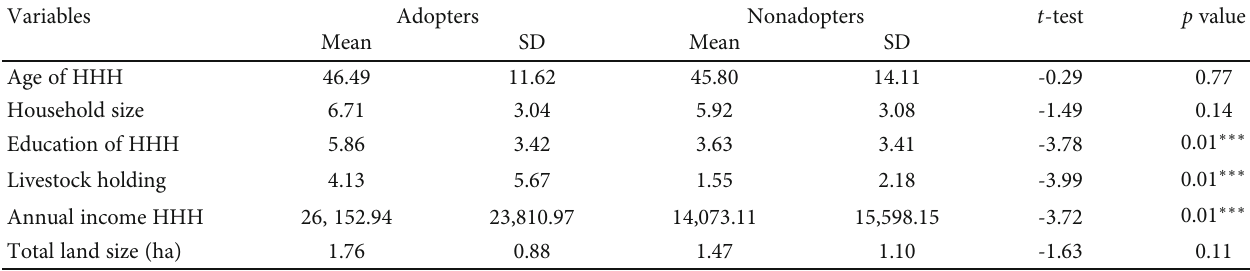
Table 1: Socioeconomic characteristics of respondents ( n = 51 adopters, and n = 97 nonadopters).